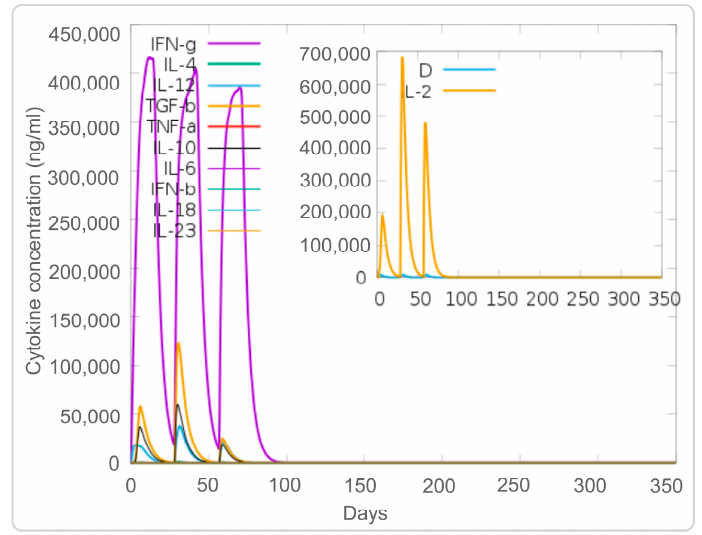
Figure 7. Cytokines induced by PP19128R vaccination. Simulated immunization with the PP19128R vaccine was performed three times by the C-immune server in silico, and the levels of cytokines were analyzed.